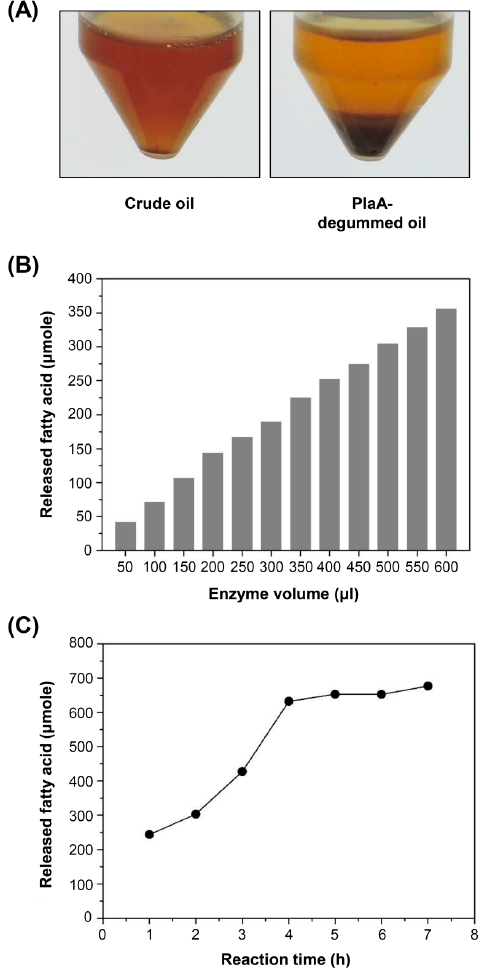
Figure 5. Degumming crude oil and lecithin hydrolysis using the culture supernatant of PlaA. ( A ) The crude sesame oil was incubated with 10 µ g PlaA solution for 24 h at 40 ◦ C. ( B ) Di ff erent amounts of PlaA solution were added to the substrate solution. After 2 h of incubation at 40 ◦ C, the conversion of lecithin to lysolecithin was measured. ( C ) The conversion of lecithin to lysolecithin by the secreted PlaA was measured at various reaction